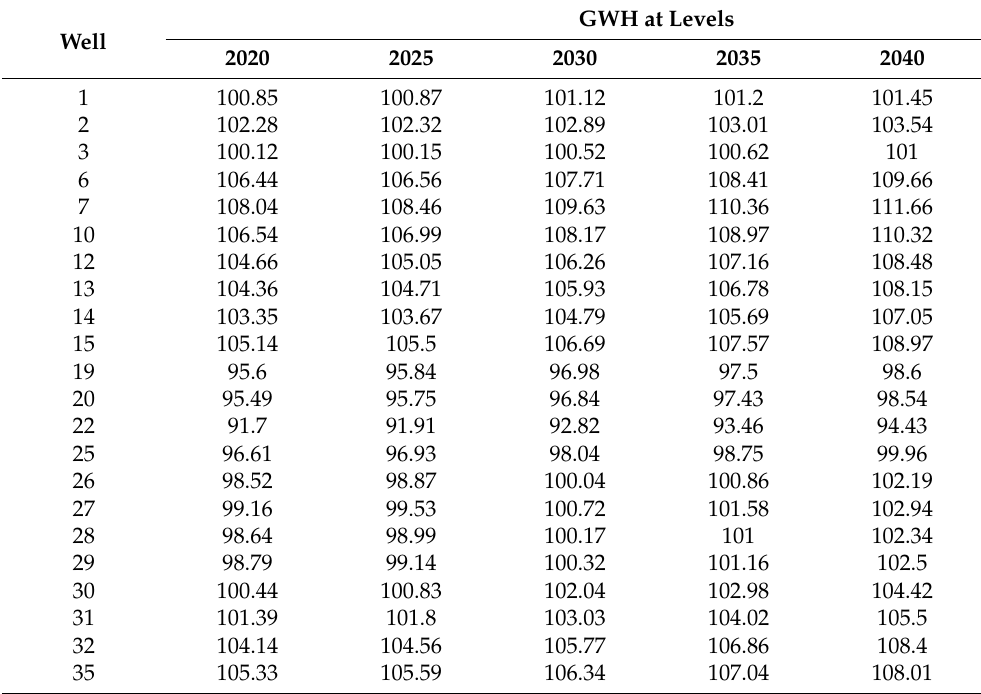
Table 2. Prediction GWH and observation well number at the leakage from the drinking water and sewage networks.